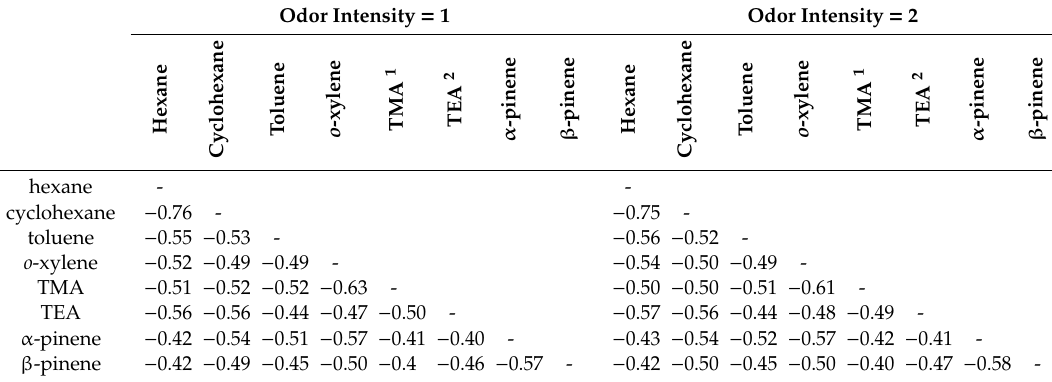
Table 7. U model odor interaction coe ffi cients.